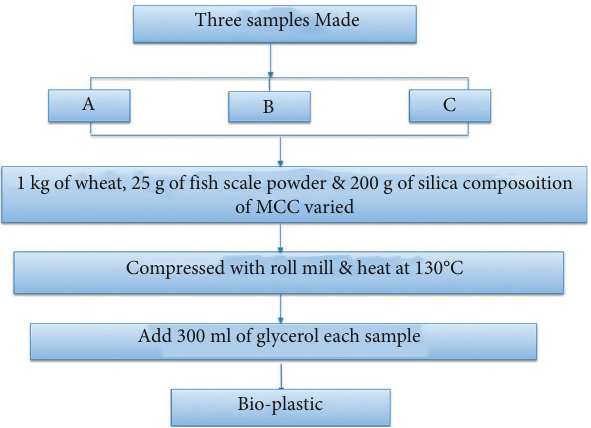
Figure 3: Flow diagram for the production of